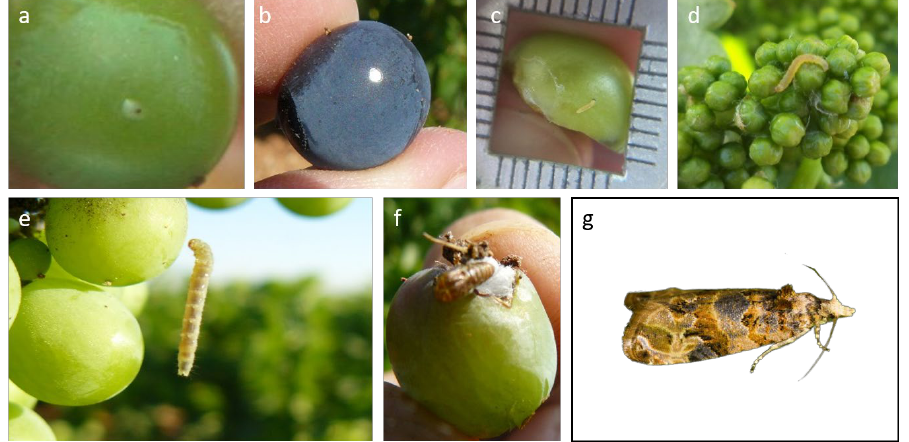
Figure 1. Different stages of development of Lobesia botrana : ( a , b ) Eggs; ( c – e ) larvae; ( f ) pupae; ( g ) adults. Photo credit: Julio Prieto-Díaz.